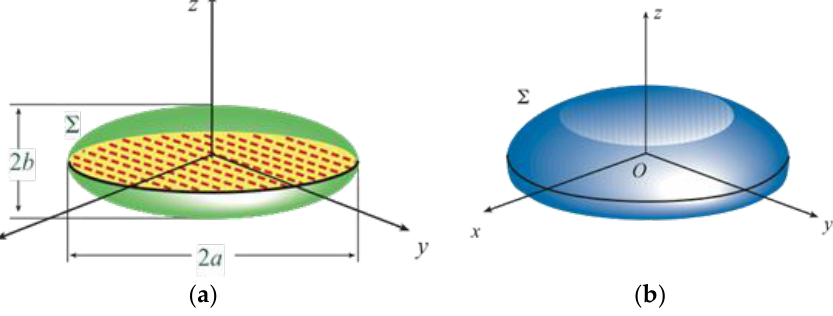
Figure 2. ( a ) Oblate spheroidal modelling. ( b ) Double bowl modelling.